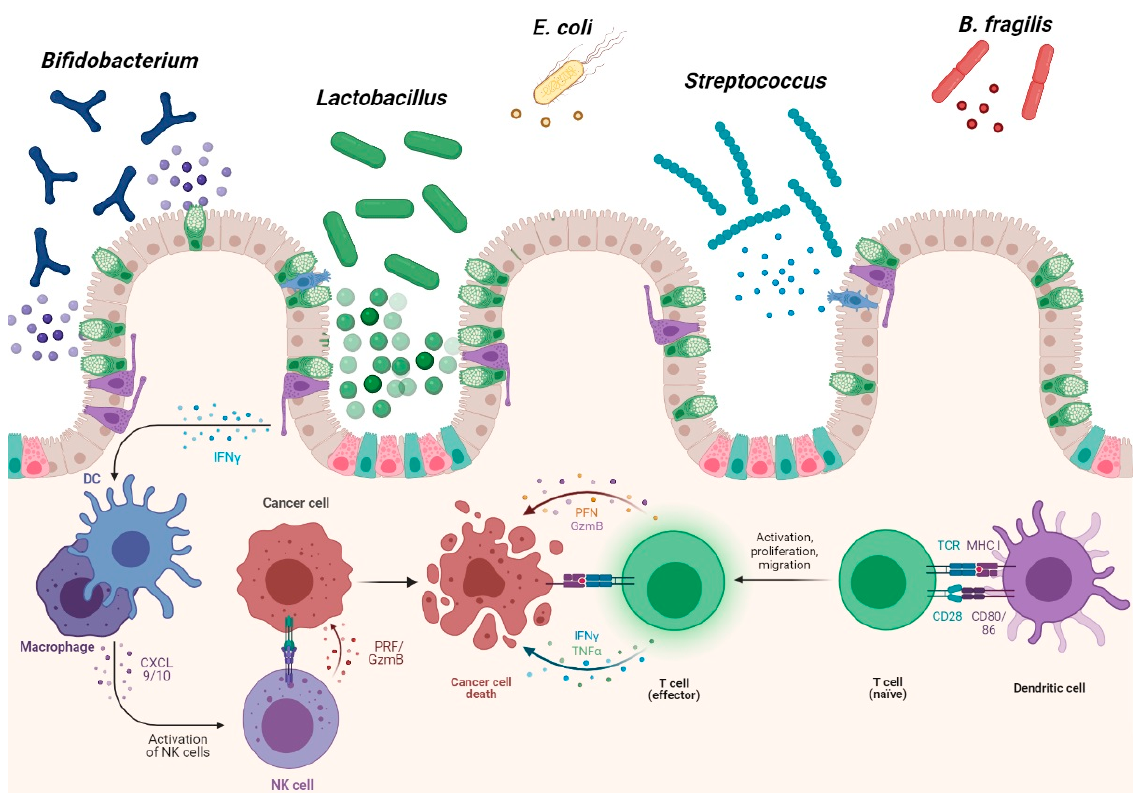
Figure 4. Positive effects of microbiota and probiotics in CRC. Some probiotic strains and their metabolites are able to enhance the intestinal immune system by inhibiting the development of cancer cells. Probiotics promote macrophage and dendritic cell differentiation, enhancing the activation of cytotoxic T-cells and NK cells. (The figure was created with Bio-render.com).